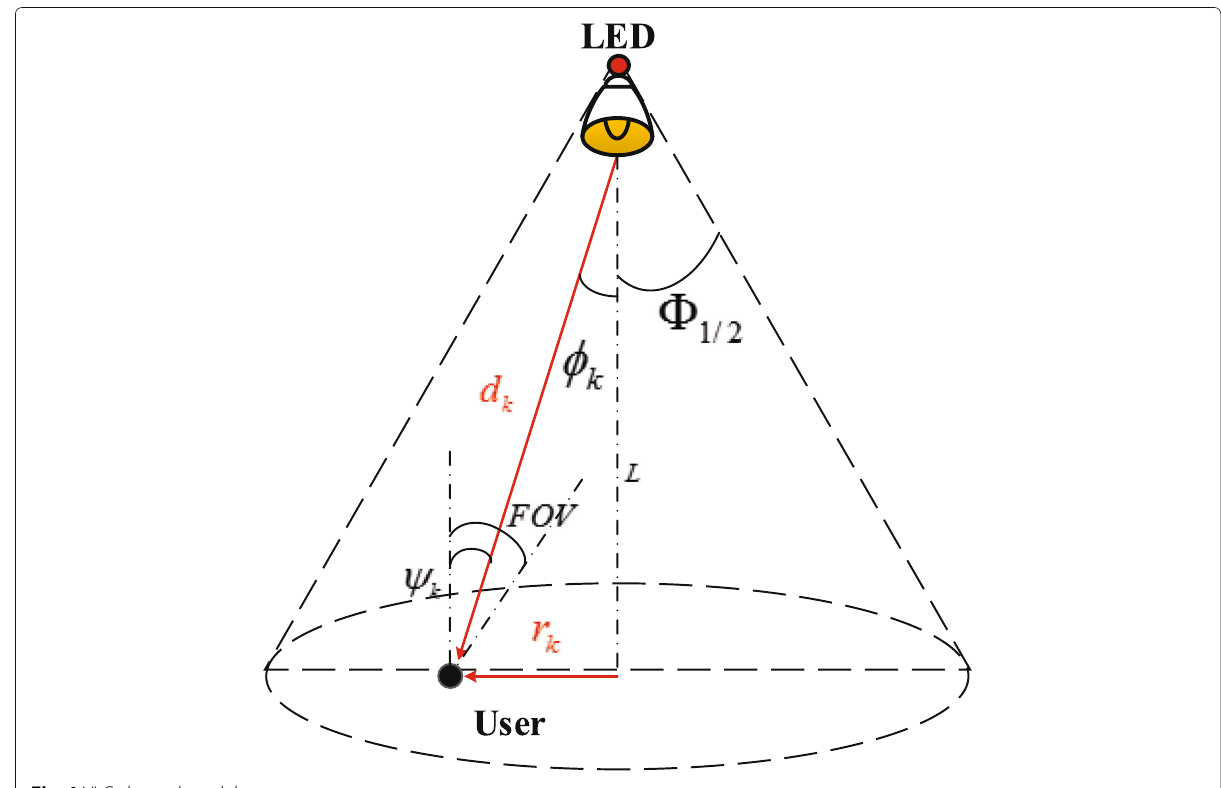
Fig. 1 VLC channel model